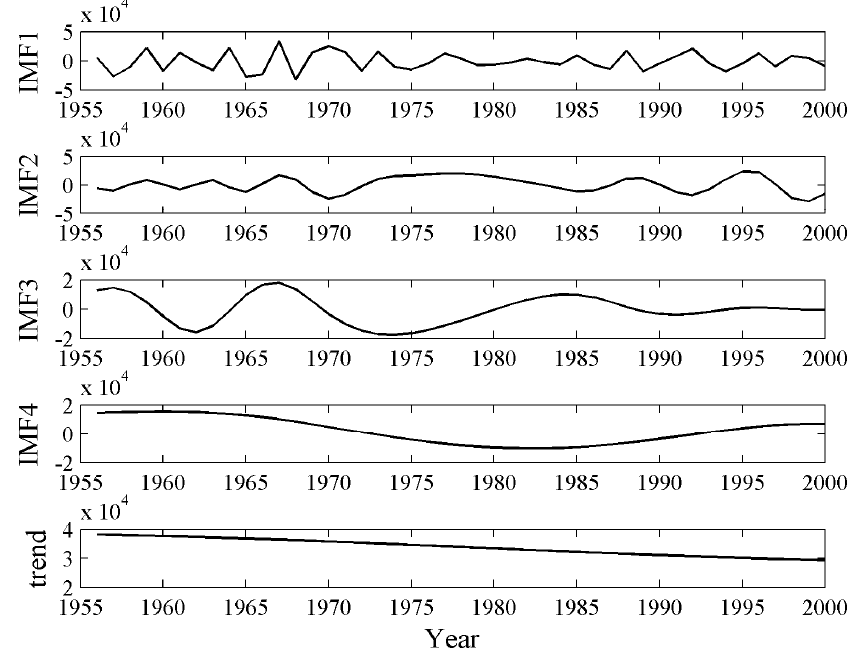
Figure 8. EMD results of runoff series for Lancun station.